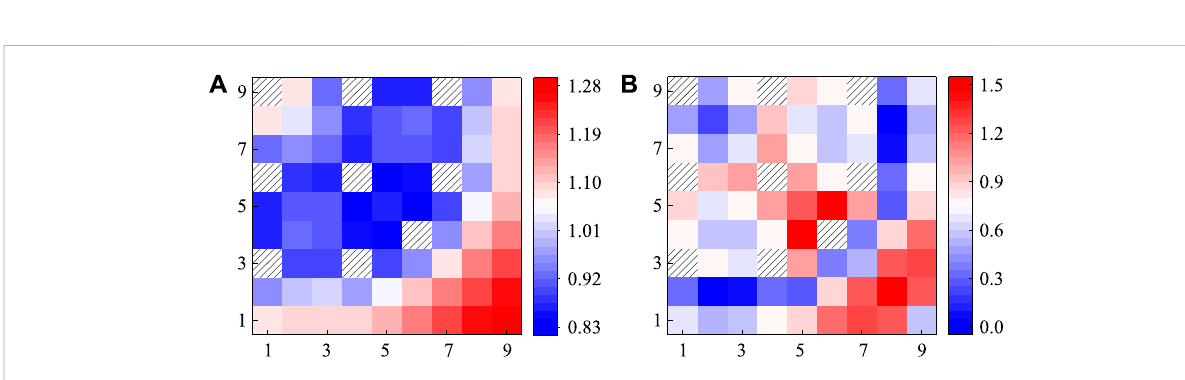
FIGURE 18 Calculation results of pin power of the VERA 2G lattice: (A) referenced normalized pin power; (B) absolute value of relative deviation/%.